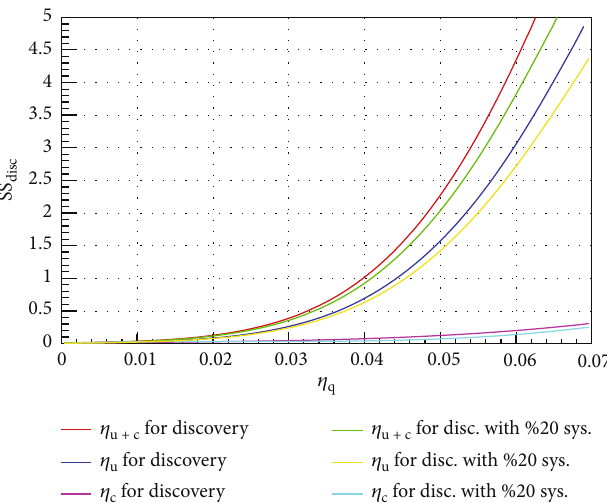
Figure 21: Signal signi fi cance ( SS